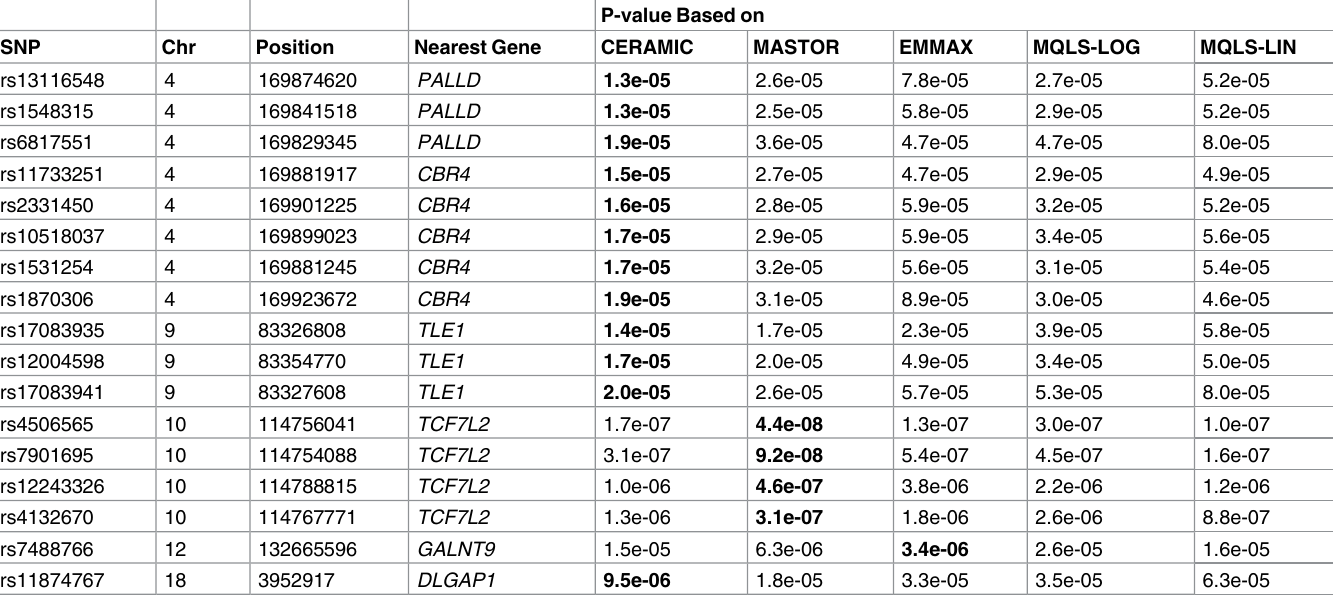
Table 6. SNPs with Strongest Association with Type 2 Diabetes in the Framingham Heart Study.